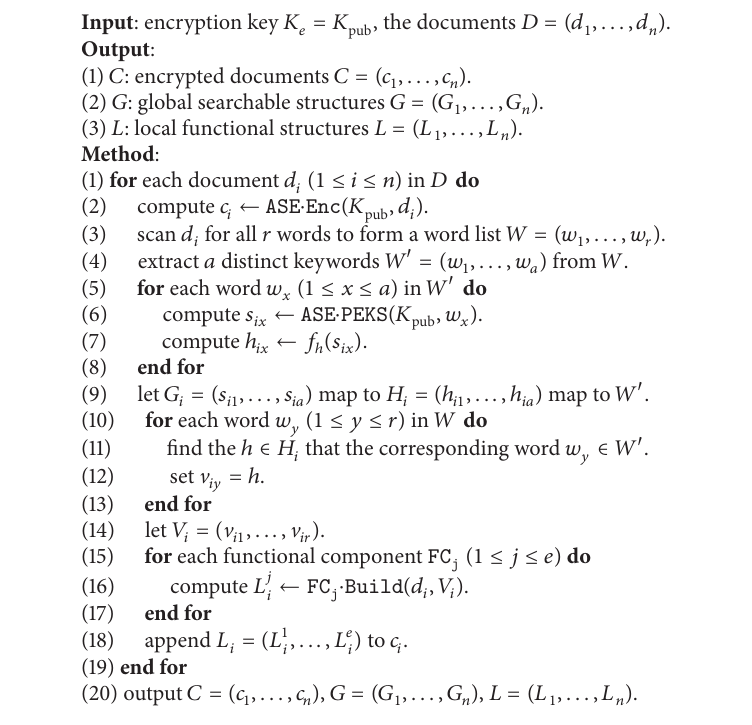
Algorithm 5: Encryption (asymmetric): Enc (𝐾 𝑒 , 𝐷 ).